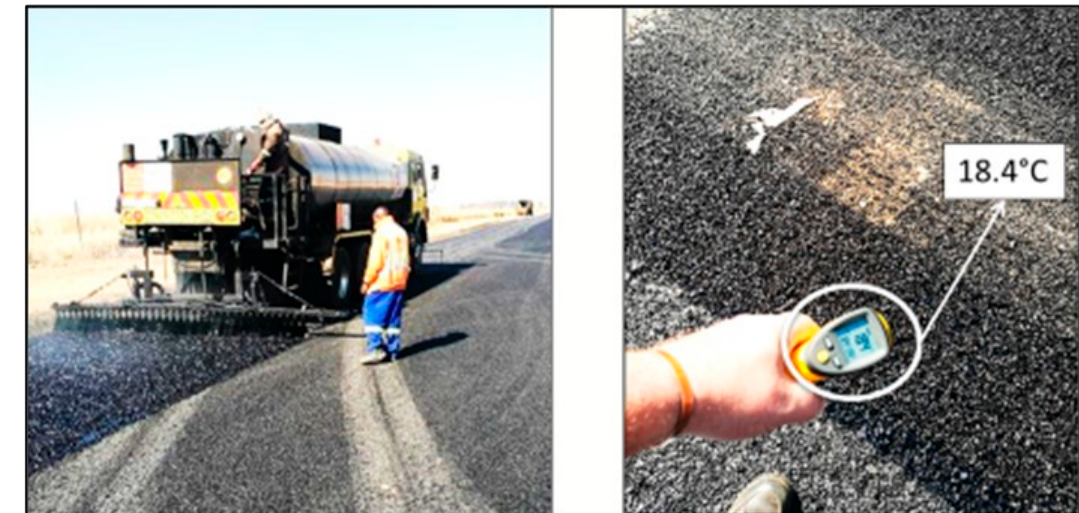
Figure 4. Placement of the SASOBIT-M ® tack coat for the 20 mm chips (stone).